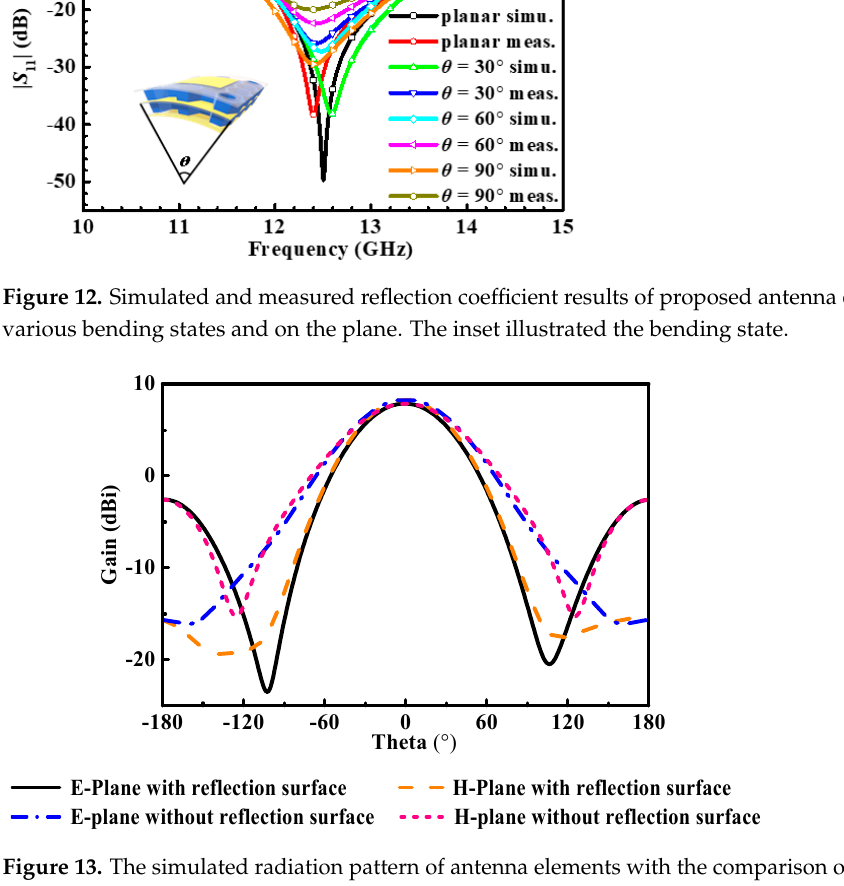
Figure 13. The simulated radiation pattern of antenna elements with the comparison of the reflection surface loaded both before and after.